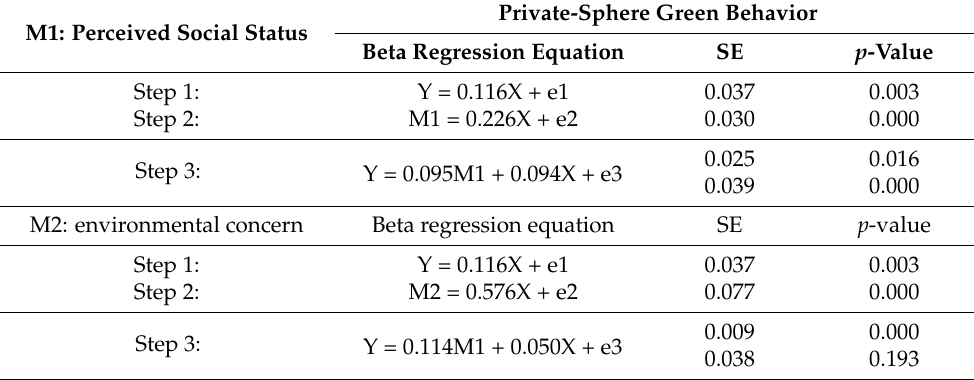
Table 4. Results of mediating effects by stepwise regression